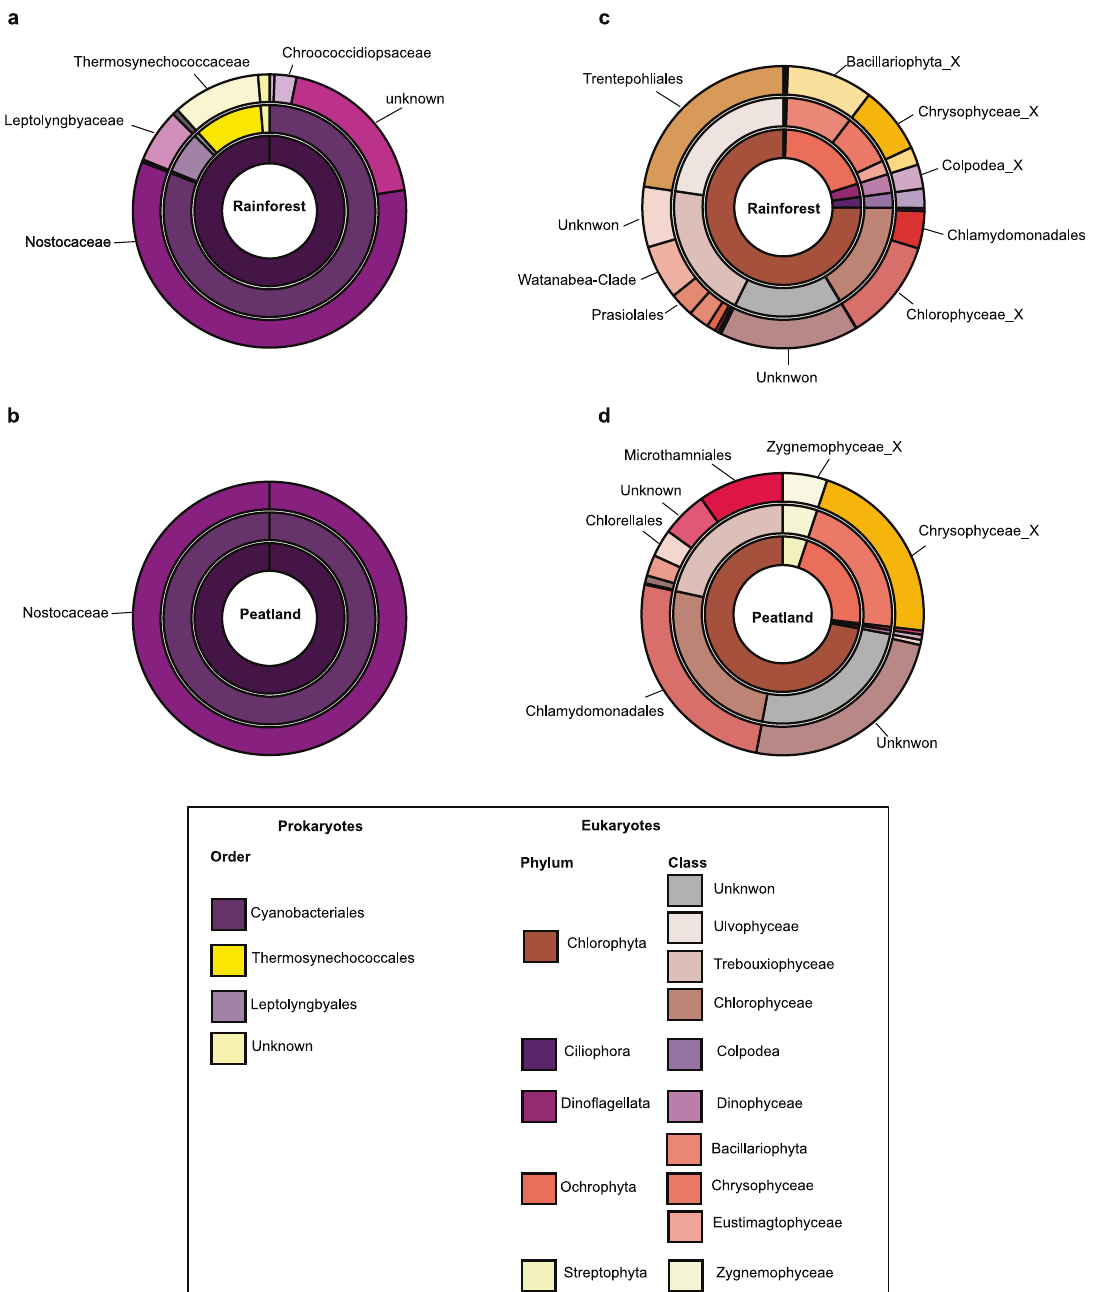
Fig. 1 Relative abundance and proportions of dominant photosynthetic bacteria and protists in the boreal peatland and tropical rainforest. Donut plots showing the relative abundance of the different photosynthetic taxa identi fi ed with 16 S ( a , b ) and 18 S ( c , d ) metabarcoding and averaged for each climatic area. The inner, middle and external circles show the relative abundance at the phylum, class and order levels,